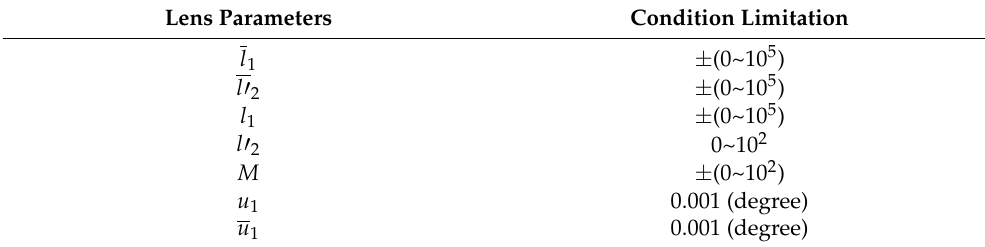
Table 1. The condition limitations for random optical